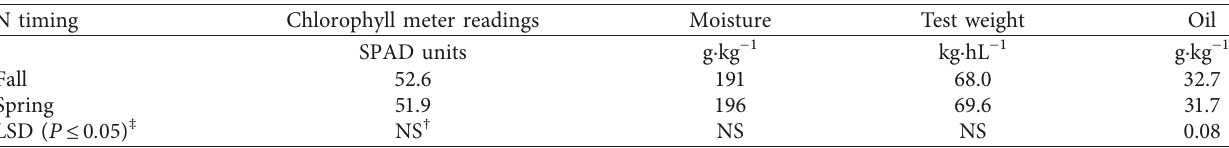
Table 7: Fall and spring chlorophyll meter readings, moisture, test weight, and oil concentration response to nitrogen sources at 168kg · N · ha − 1 . Data were combined over years and N